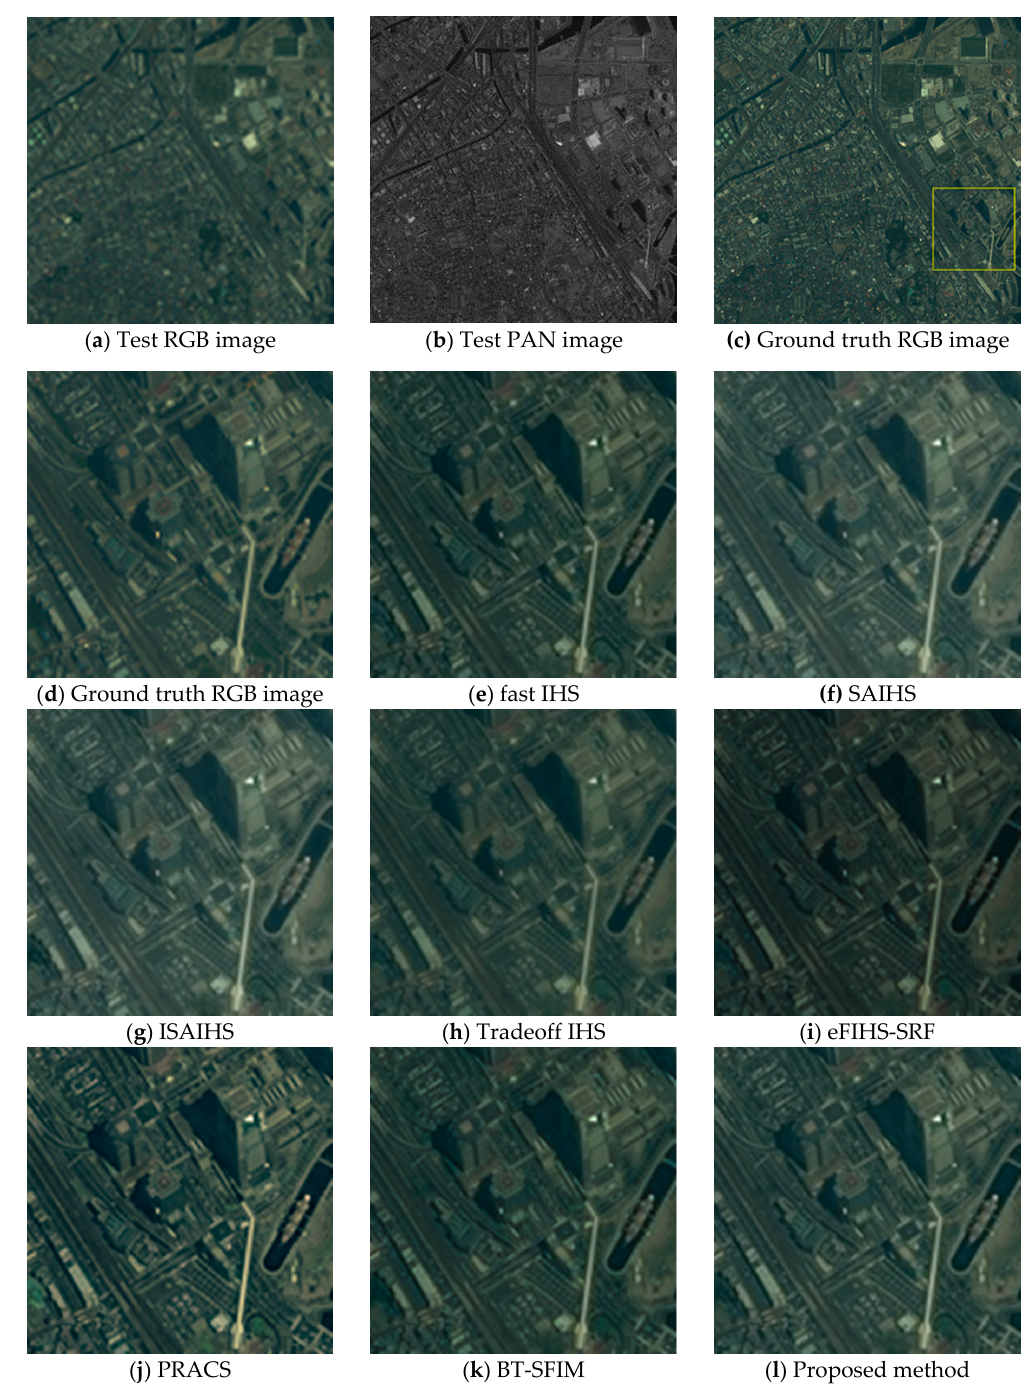
Figure 4. Visual comparison of test Nihonmatsu images: ( a ) Test red–green–blue (RGB) image; ( b ) Test PAN image; ( c ) Ground truth RGB image (i.e., Original RGB image); ( d ) Ground truth RGB image of the yellow box area in (c); ( e–l ) PS images generated by various methods corresponding to the area of (d); The red arrow indicates where the forest colors are well reproduced. The green arrow indicates where the color of the rice field is dark. White arrows indicate where the green tones are light.